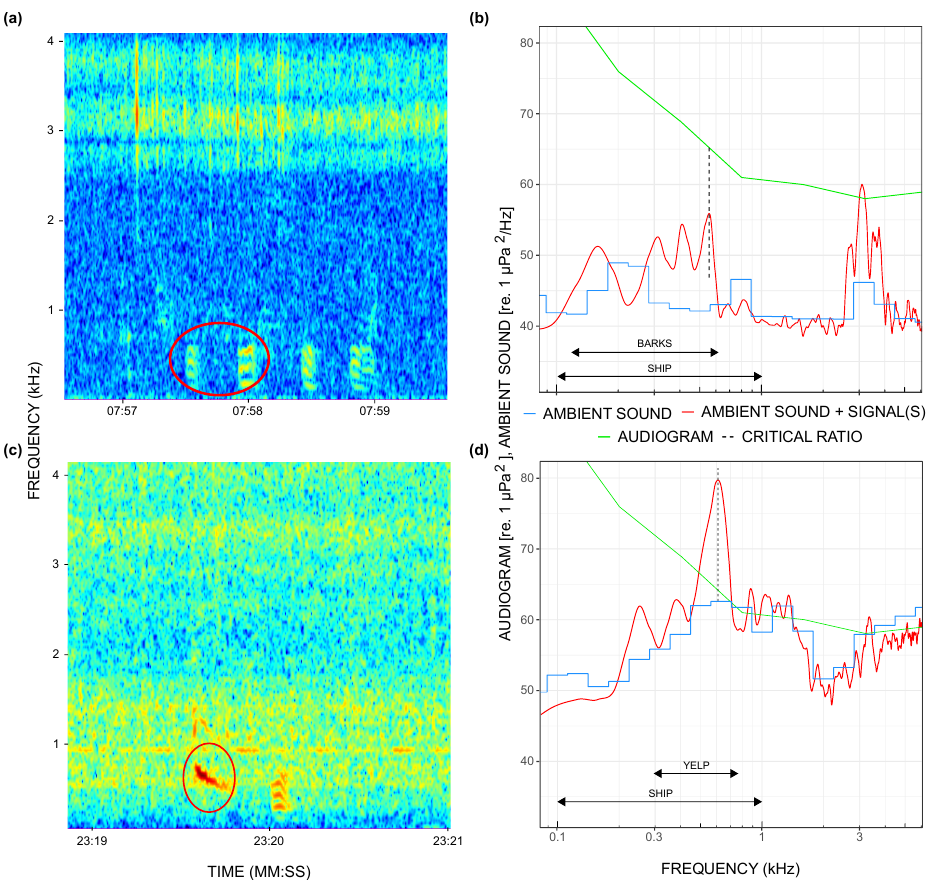
Figure 12. Masking potential estimation of the co-occurrence cases of ringed seal calls with anthro- pogenic sound from distant shipping. Vocalisations are marked on the spectrograms by red ovals ( a ) bark and ( c ) yelp. On the right side, the spectral overlaps of two masking events are shown. In ( b ), hearing is audiogram limited, and masking does not occur. In ( d ), hearing is shipping-noise limited, and masking is likely. Blue lines show the mean-square sound pressure spectral density level of the ambient sound averaged in